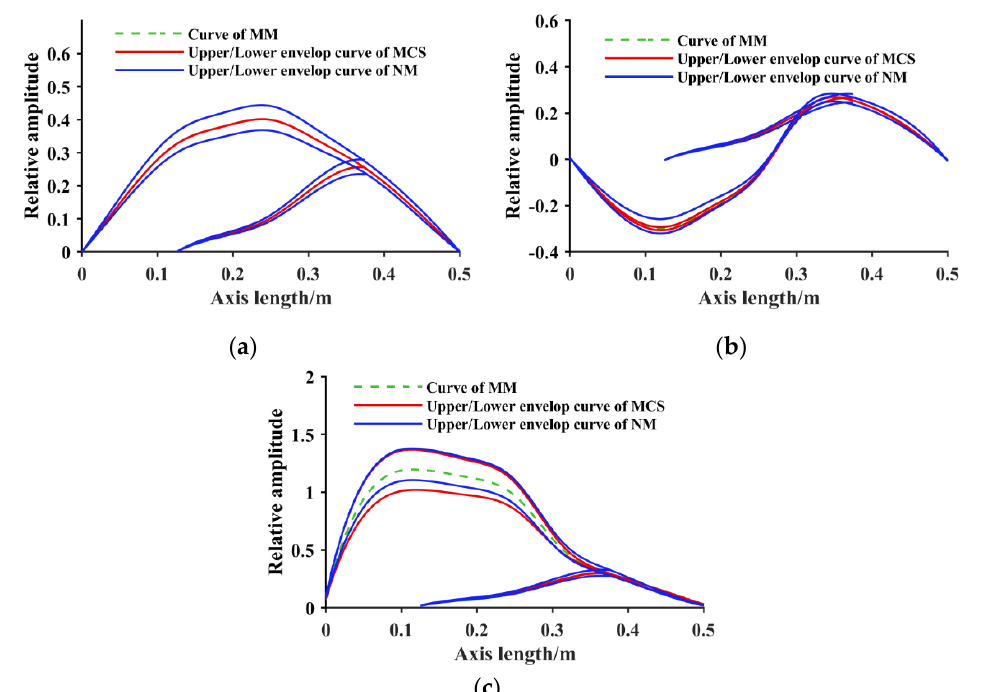
Figure 8. Upper and lower boundaries of the first three ‐ order vibration modes of two rotors for C ov , m = 0.20. ( a ) The first ‐ order vibration mode. ( b ) The second ‐ order vibration mode. ( c ) The third ‐ order vibration mode.